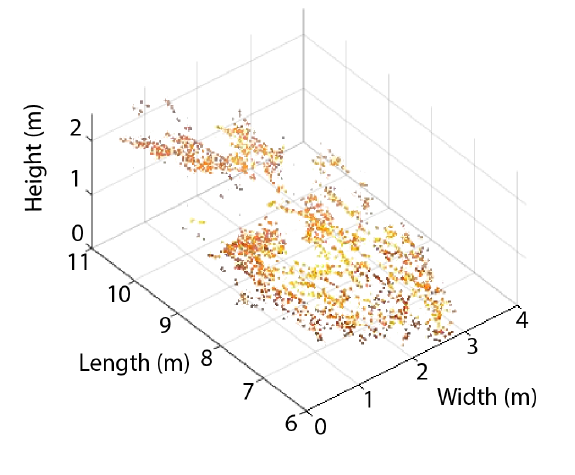
Figure 23. 3D points computed from the fire stereoscopic images acquired at t = 100 s.